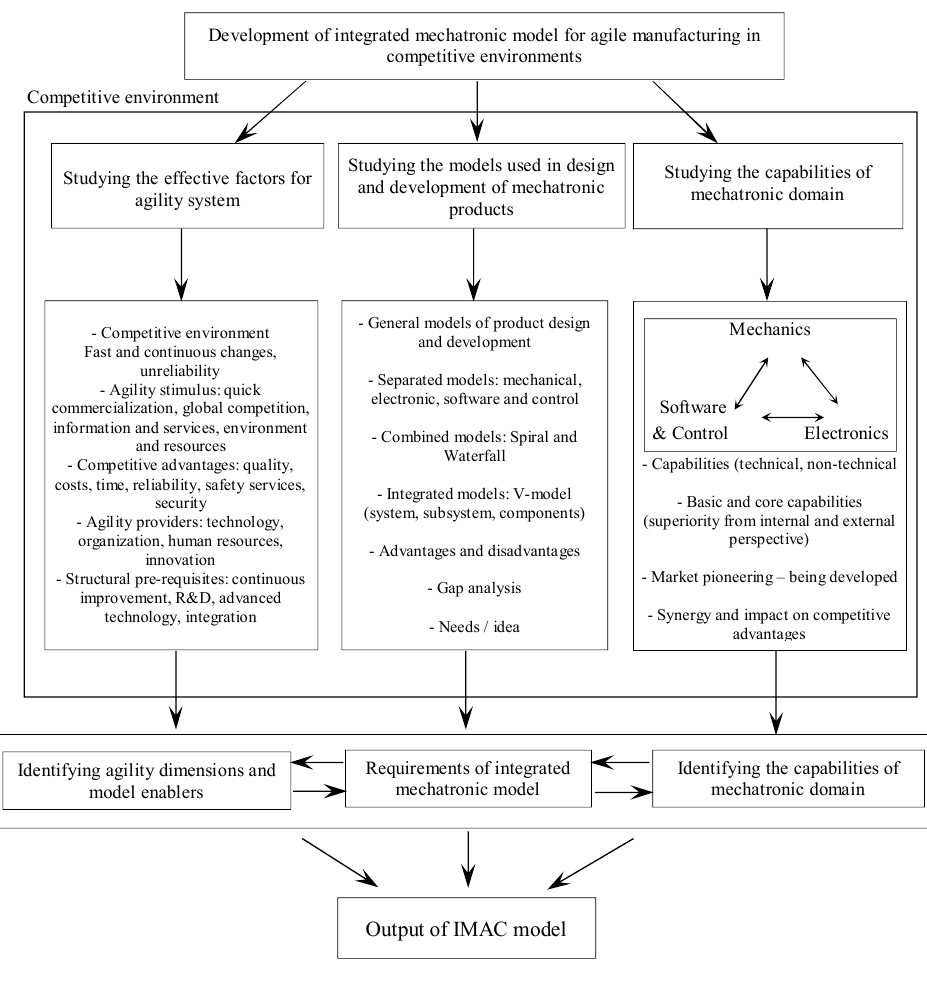
Fig 2 . Development process for integrated mechatronic production model for agile manufacturing in competitive